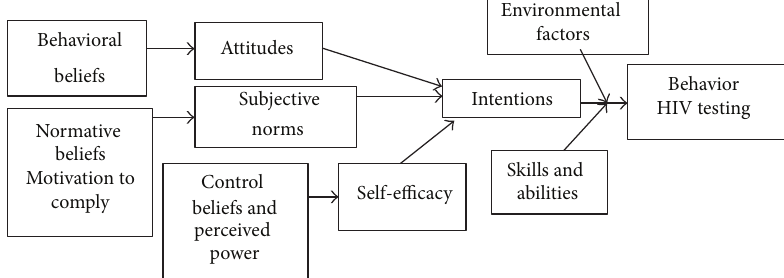
Figure 1: Conceptual model of constructs influencing intentions to undergo HIV testing (adapted from the integrated model of behavior;